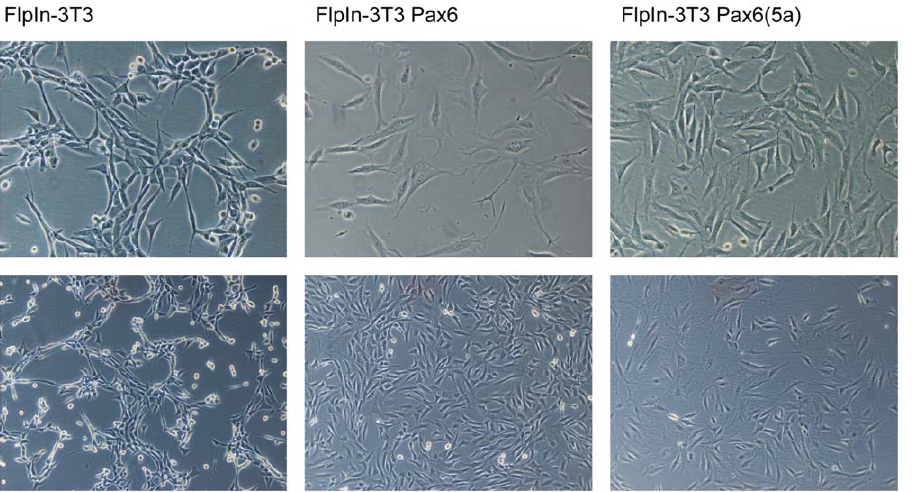
Figure 7. The FlpIn-3T3 Pax6 and FlpIn-3T3 Pax6(5a) cell lines have changed morphology compared to the original FlpIn 3T3 cell line they were generated from. This was repeatedly observed over several passages. Pax6 and Pax6(5a) expressing cells appeared more flattened and seemed to have more protrusions. The cells on the picture have passage numbers 17, 15 and 11 for the FlpIn-3T3, FlpIn-3T3 Pax6 and FlpIn-3T3 Pax6(5a) respectively. For the pictures on the upper row a 20 6 magnification is used, for the lower row a 10 6 magnification is used on a Zeizz Axiovert S100 Microscope with a Nikon Digital Sight DS-5 M camera.